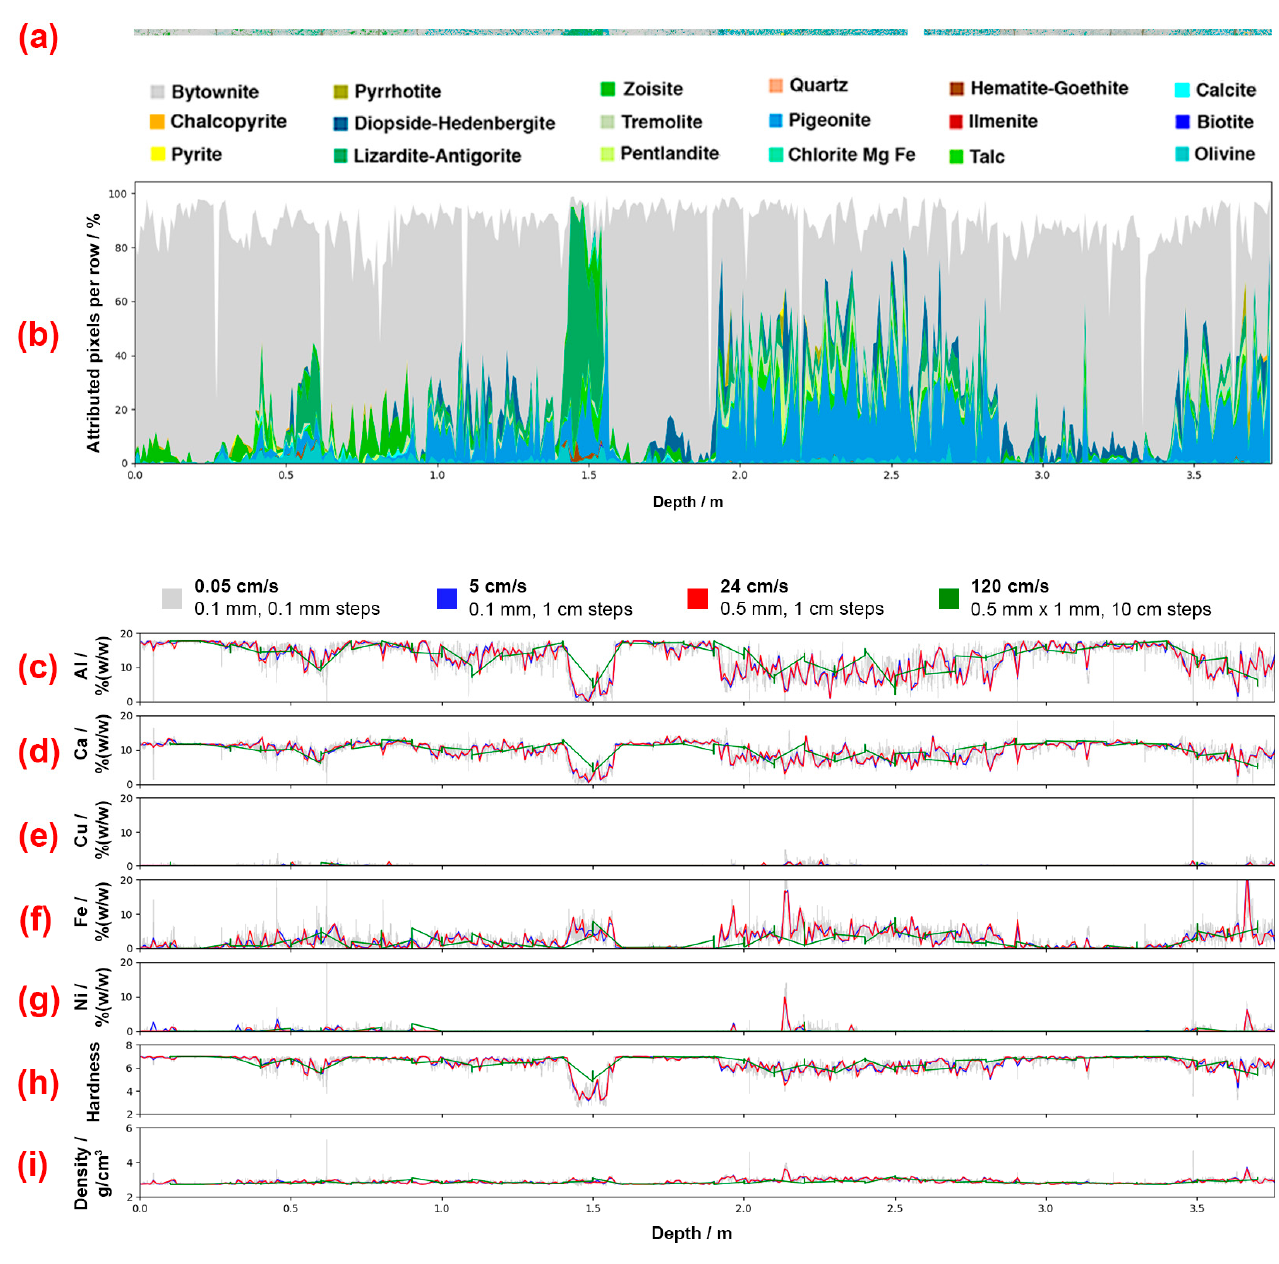
Figure 8. ( a ) Mineral map of the entire core in the box, ( b ) mineral content in % as a function of core length at 10 mm steps, ( c – g ) elemental assay, ( h ) hardness, and ( i ) density. Scanning speeds are 0.05 cm/s (grey, 0.1 mm steps), 5 cm/s (green, 10 cm steps), 5 cm/s (blue, 1 cm steps), and 24 cm/s (red, 1 cm steps) along the depth axis.